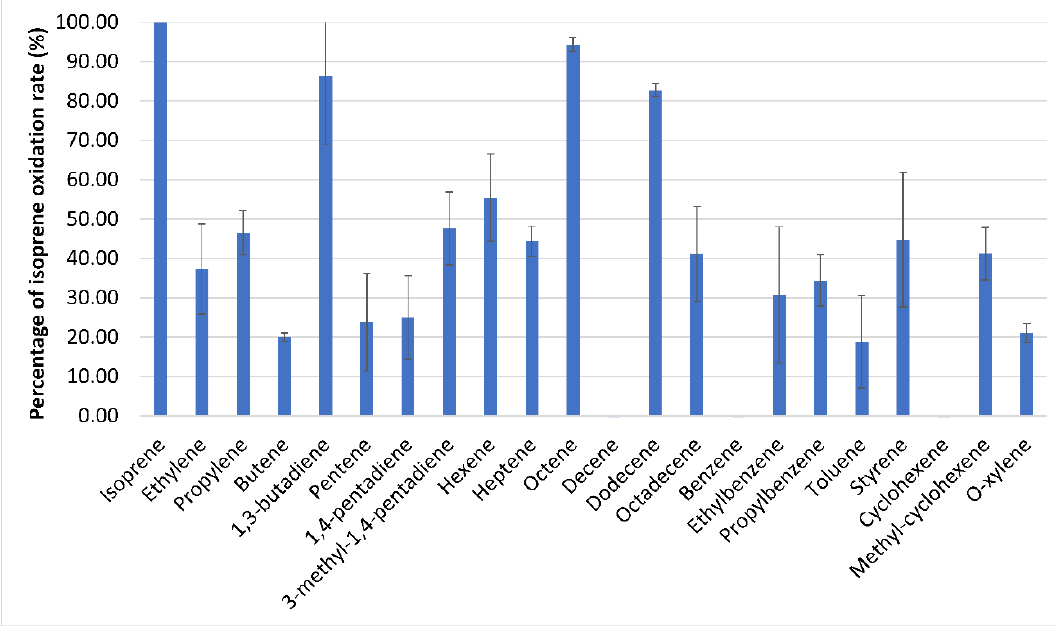
Figure 4. Relative rates of substrate-dependent oxygen uptake by isoprene-grown Variovorax sp. WS11, where 100% is 31.2 nmoL/min/mg dry weight.